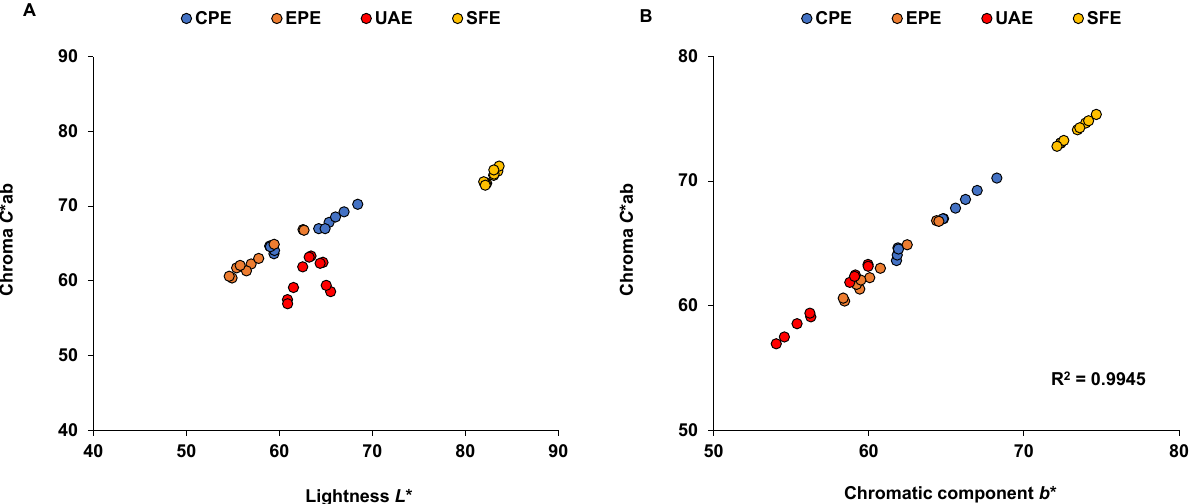
Figure 2. ( A ) Chroma vs. lightness plot and changes in the chroma values for the different sinami oil extraction systems; ( B ) correlation between chromatic parameter b * and chroma value in the sinami oil that was obtained using CPE, EPE, UAE and SFE. The colorimetric coordinate a * ranged between − 19.23 and − 10.06 units for the different extraction methods, with UAE ( − 19.23) > CPE ( − 17.20) > EPE ( − 16.80). Values ranging from − 3.84 to − 0.24 units have been reported for some single varietal virgin olive oils [68], whereas other commercial oils, such as sacha inchi oil, have shown values between − 62 and − 3.62 units [40]. K ı l ı ç et al. [71] reported a * values of − 1.8 and − 1.2 for corn oil and sunflower oil, respectively. The more negative a * values may be influenced by plant pigments, especially chlorophylls. Olive oils of different Italian varieties have shown a * values from − 9.00 to − 3.33 units [72]; therefore, negative values of a * correspond to a green color. In addition, a negative correlation between the chlorophyll content and a * value was found (r = − 0.64). Nevertheless, it was also highlighted that the higher the chlorophyll content, the darker and greener the oils. The distribution of the sinami oils that were extracted using the different methods could be observed in the a * b * plane. The oils were found in the second quadrant, which corresponded to negative values of a * and positive values of b * (Figure 3). In terms of h ab, the values were between 71.46° and 82.17°, thus placing the sinami oils that were extracted using UAE, CPE, EPE and SFE in the green-yellow color area. The yellowest sinami oil was obtained using SFE, whereas the oils that were derived using CPE (75.03°) and EPE (74.54°) were statistically equal. Olive oils have shown h ab values of between 90.77° and 95.95° [68].